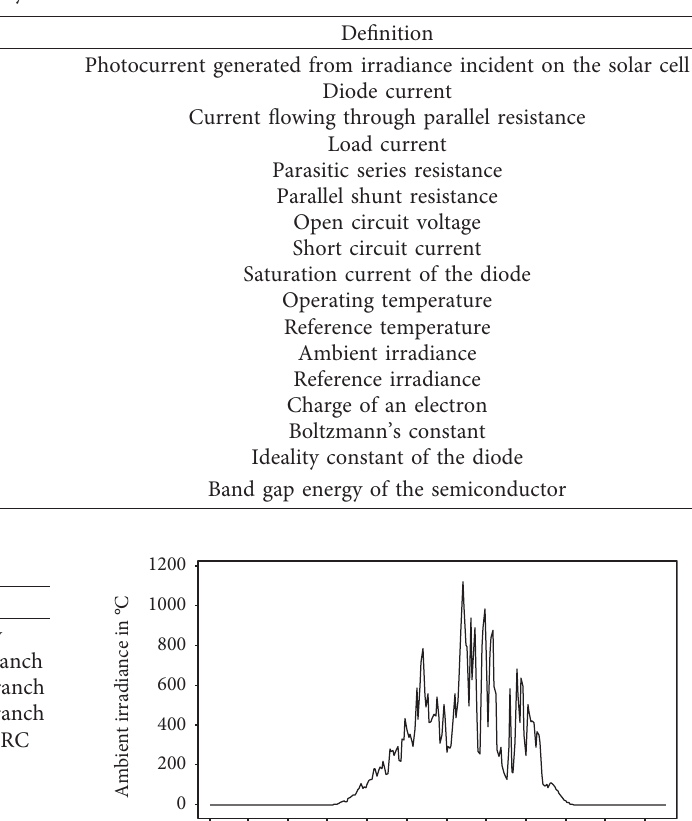
Table 1: Summary of notations and definitions.